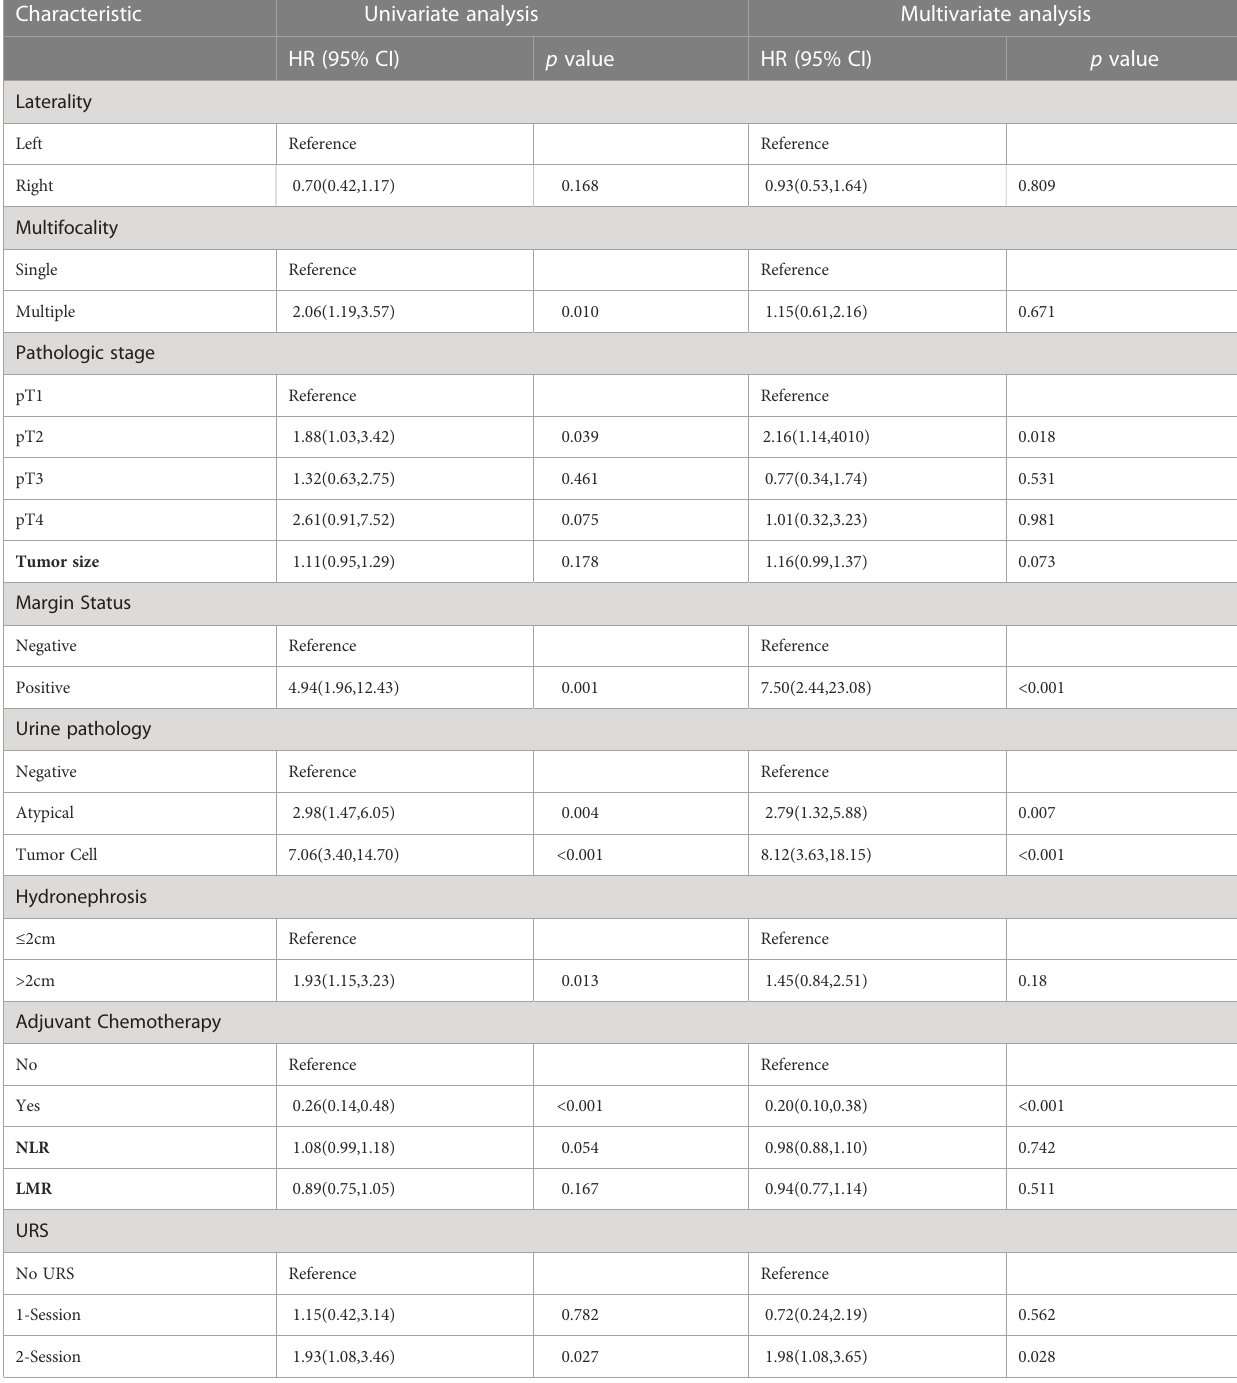
TABLE 3 Risk factors for predicting IVR following RUN for UTUC in 220